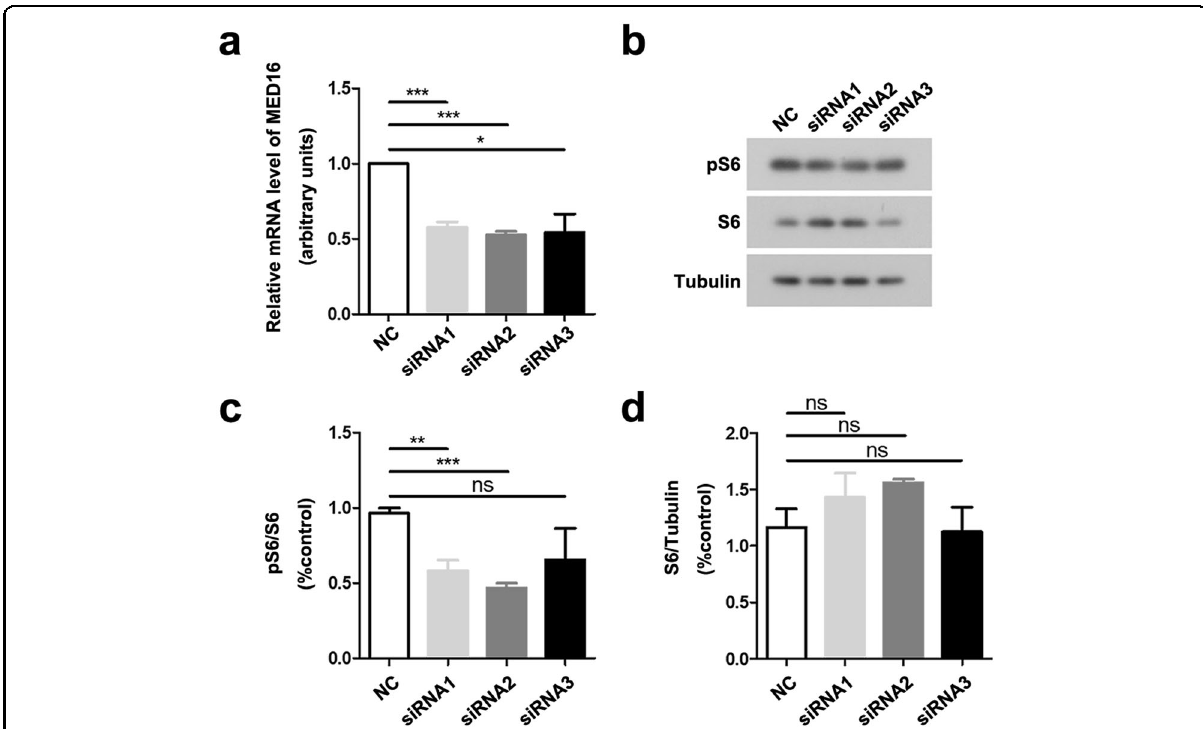
Fig. 6 Downregulation of MED16 reduces S6 phosphorylation. HEK293T cells were transfected with scrambled control siRNA (NC) or MED16 siRNAs (siRNA1, siRNA2, and siRNA3) for 48 h. a The relative MED16 mRNA levels in transfected cells were quanti fi ed by quantitative real-time PCR and normalized to the β -actin mRNA levels for comparison. b Cell lysates were analyzed by SDS-PAGE and immunoblotting to detect phosphorylated S6 (pS6), total S6 and α -tubulin. c The levels of pS6 were normalized to those of total S6 for comparison. d The levels of S6 were normalized to those of α -tubulin for comparison. Data are presented as the mean ± s.e.m, n = 4, * P < 0.05, ** P < 0.01, *** P < 0.001, ns: not signi fi cant (Student ’ s t